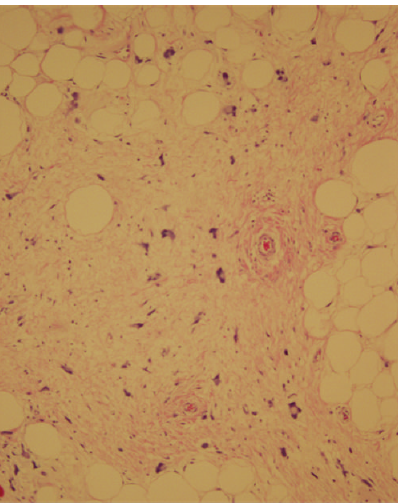
Figure 2: Light microscopy displays expanded hypercellular stroma with atypical adipocytes with enlarged nuclei and hyperchromasia.